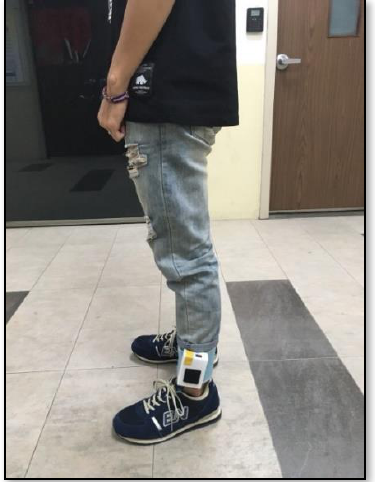
Figure 7. Static standing plantar pressure measurement position for the subject, with the insole-plantar pressure device inserted in the shoes.